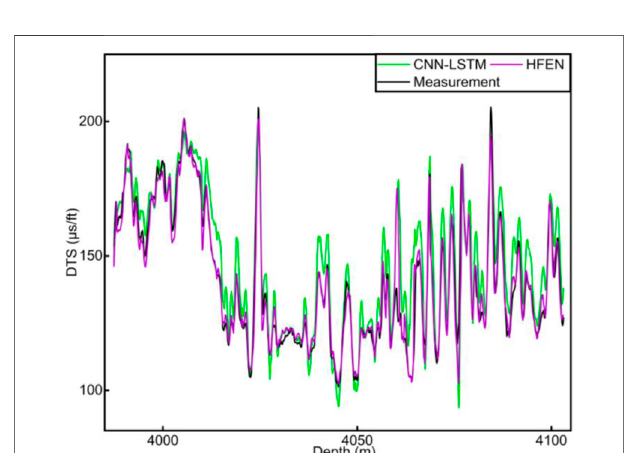
FIGURE 11 | HFEN vs. Measurement in well 1.